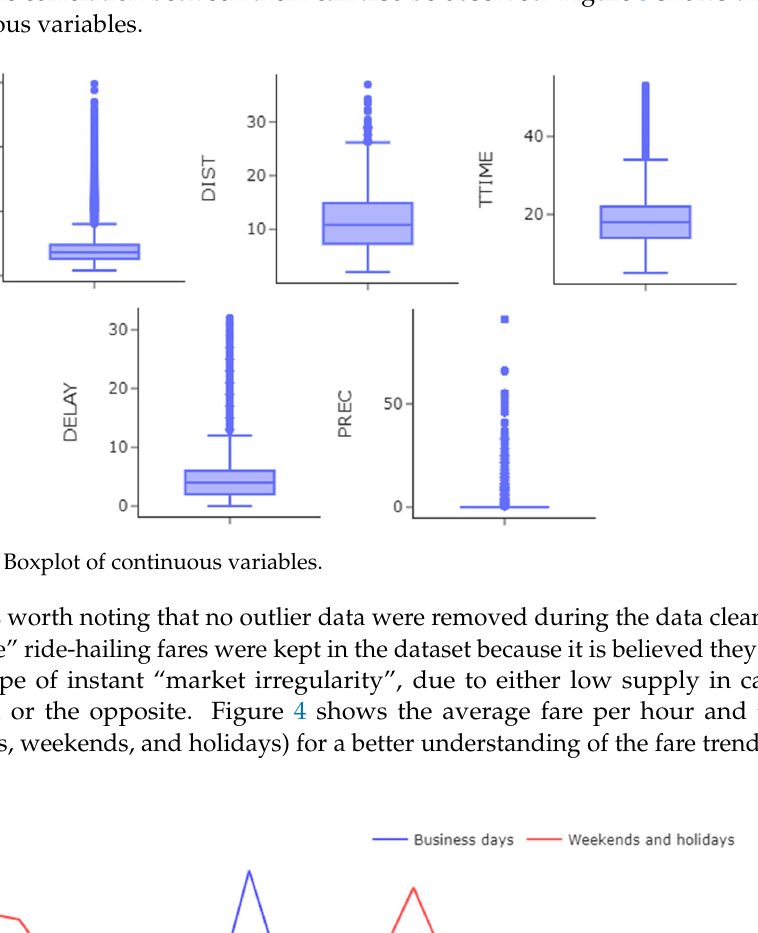
Figure 2. Pair plot of continuous variables. Notes: The points are in blue and linear regressions are in red, and the main diagonal represents kernel density estimates (KDEs).